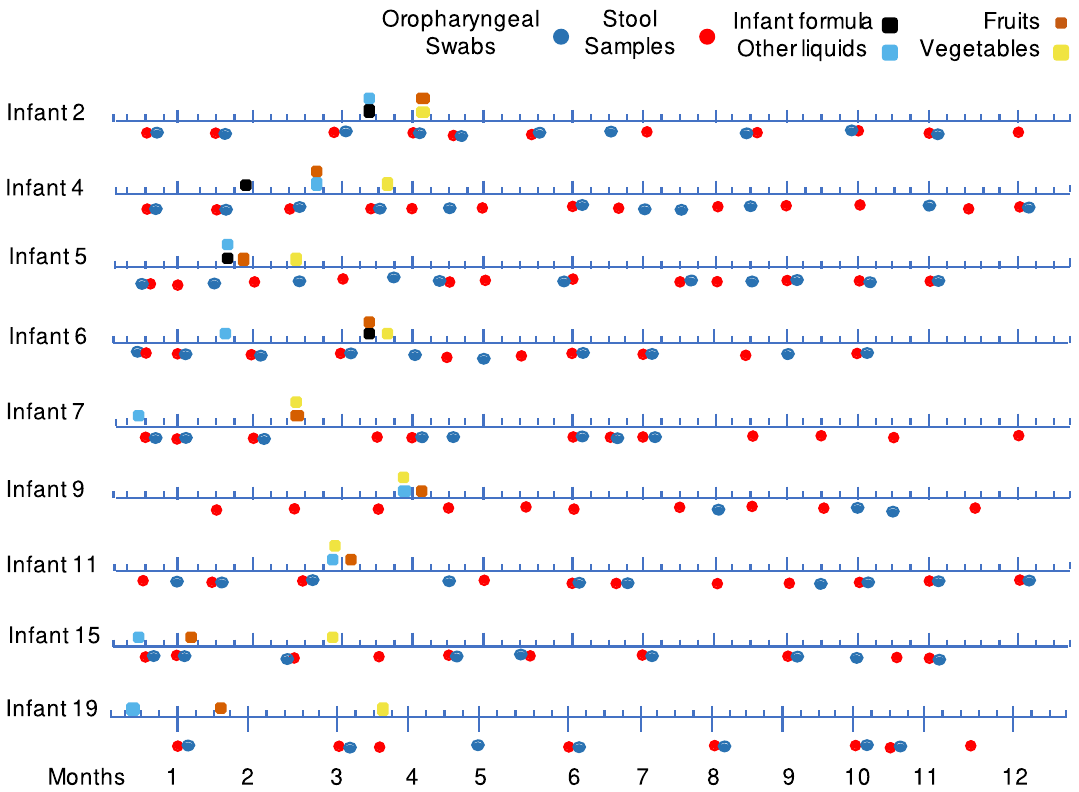
Figure 1. Timeline of the collection of stool samples (red circles) and oropharyngeal swabs (blue circles). The time is indicated as weeks and below is the equivalence in months. Squares illustrate the start of ingestion of food and liquids other than